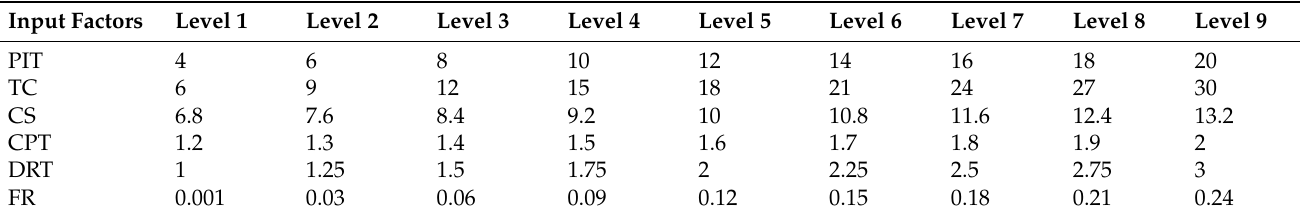
Table 2. Different levels of various input basic